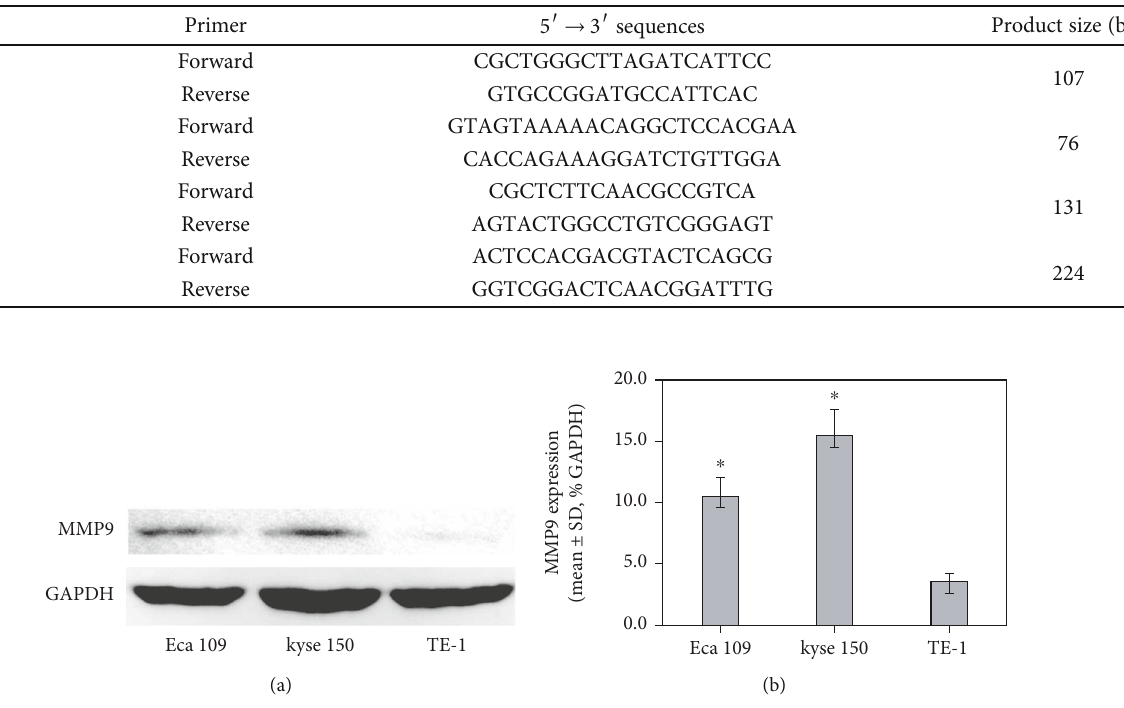
Figure 1: MMP9 protein expression in ESCC cell lines. ∗ P < 0 : 05 versus TE-1. Table 2: The weight of body, liver, and their subcutaneous tumors was